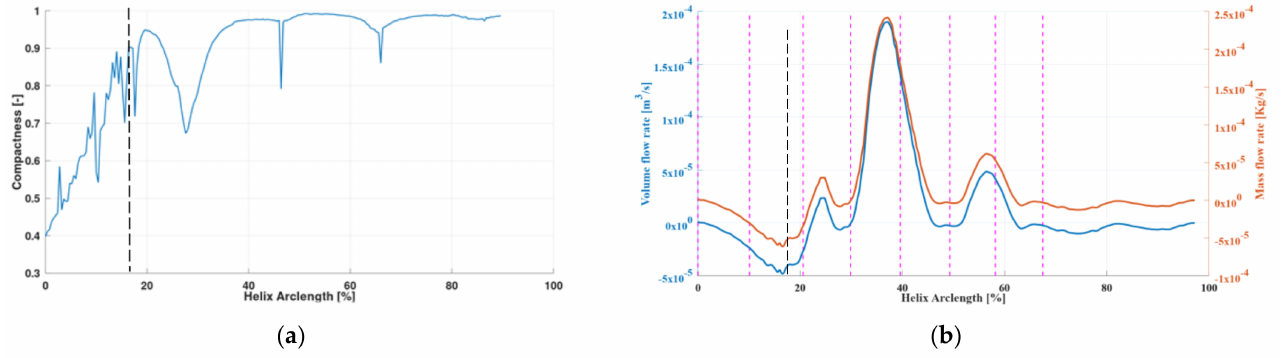
Figure 9. PPTC’11. Tip vortex longitudinal evolution analysis: ( a ) shape; ( b ) flow rate.